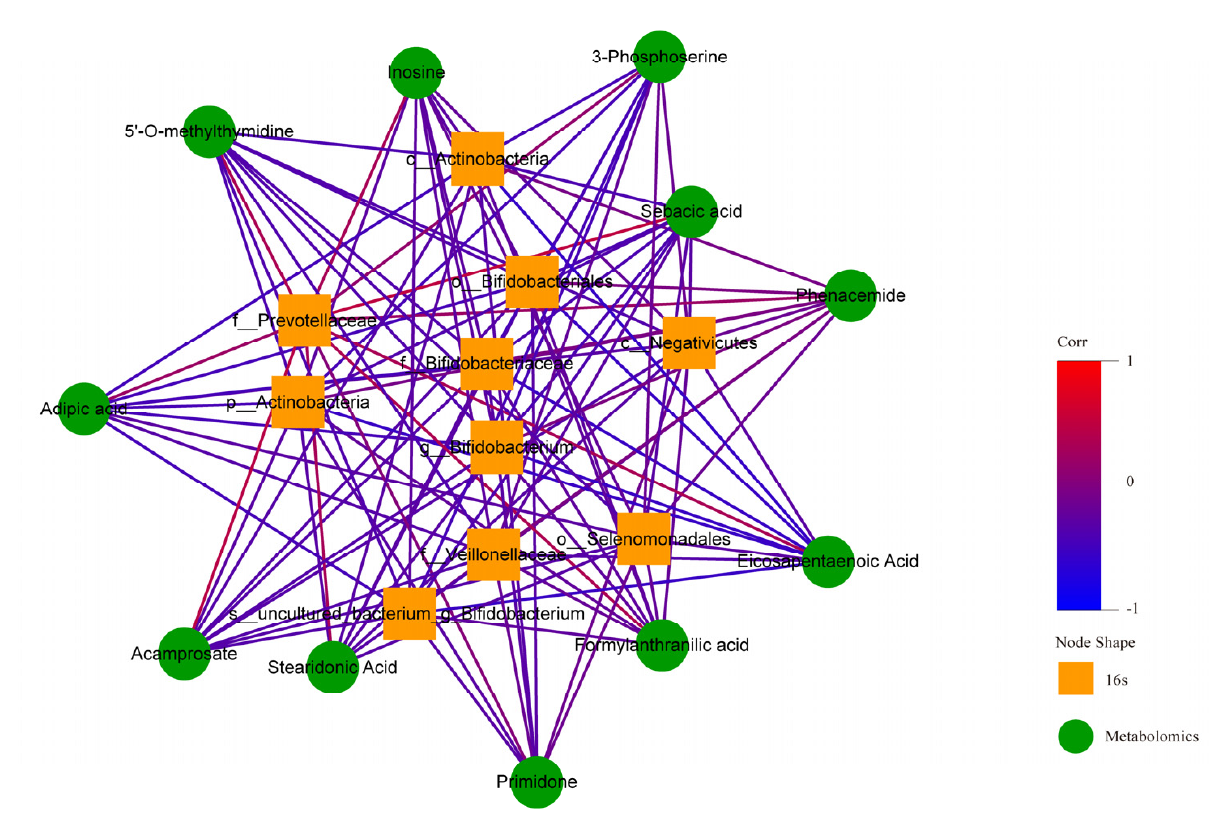
Figure 25. Correlation network diagram in negative ion mode. The thermodynamic diagram and correlation network diagram (Figures 26 and 27) show that Phe-Trp was negatively correlated with c_Actinobacteria, p_Actinobacteria, Bifidobacterium_uncultured, Bifidobacteriaceae, Bifidobacteria, Bifidobacterium, and Veil- lonellaceae in the positive ion mode. There was a negative correlation between Leu-Leu and Veillonellaceae. There was a positive correlation between L-Glutamate and Prevotel- laceae. Inosinee was negatively correlated with c_Actinobacteria, p_Actinobacteria, Bi- fidobacterium_uncultured, Bifidobacteriaceae, Bifidobacteria, and Bifidobacterium. Di- ethanolamine was the same as inosine. The ten different metabolites selected included the above five metabolites, and the above results have statistical significance. The remaining 13 metabolites were related to the flora, but the results of 9 metabolites were statistically significant, while those of 4 metabolites were not statistically